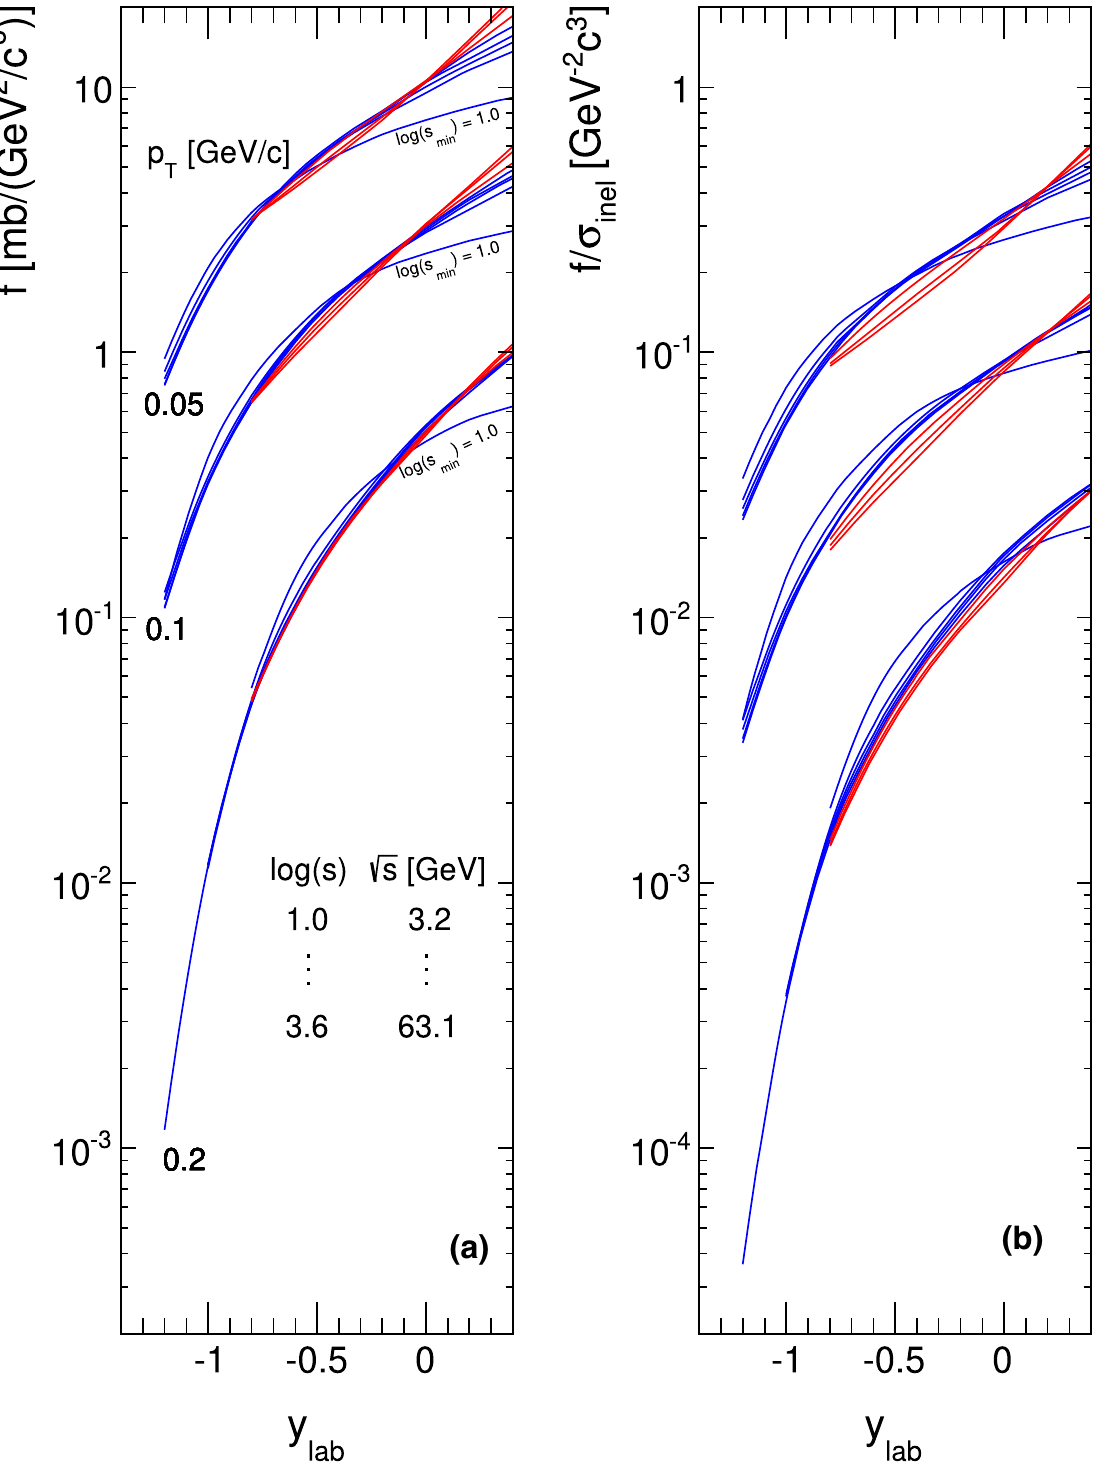
Fig. 107 π − cross sections as a function of y lab for p T = 0.05, 0.1, 0.2 GeV/c and different log ( s ) values inthe range 1 < log s < 3.6; a f ( y lab , p T ) , b f ( y lab , p T )/σ inel . The distributions for different p T values are successively scaled down by factor of 1/3 for better